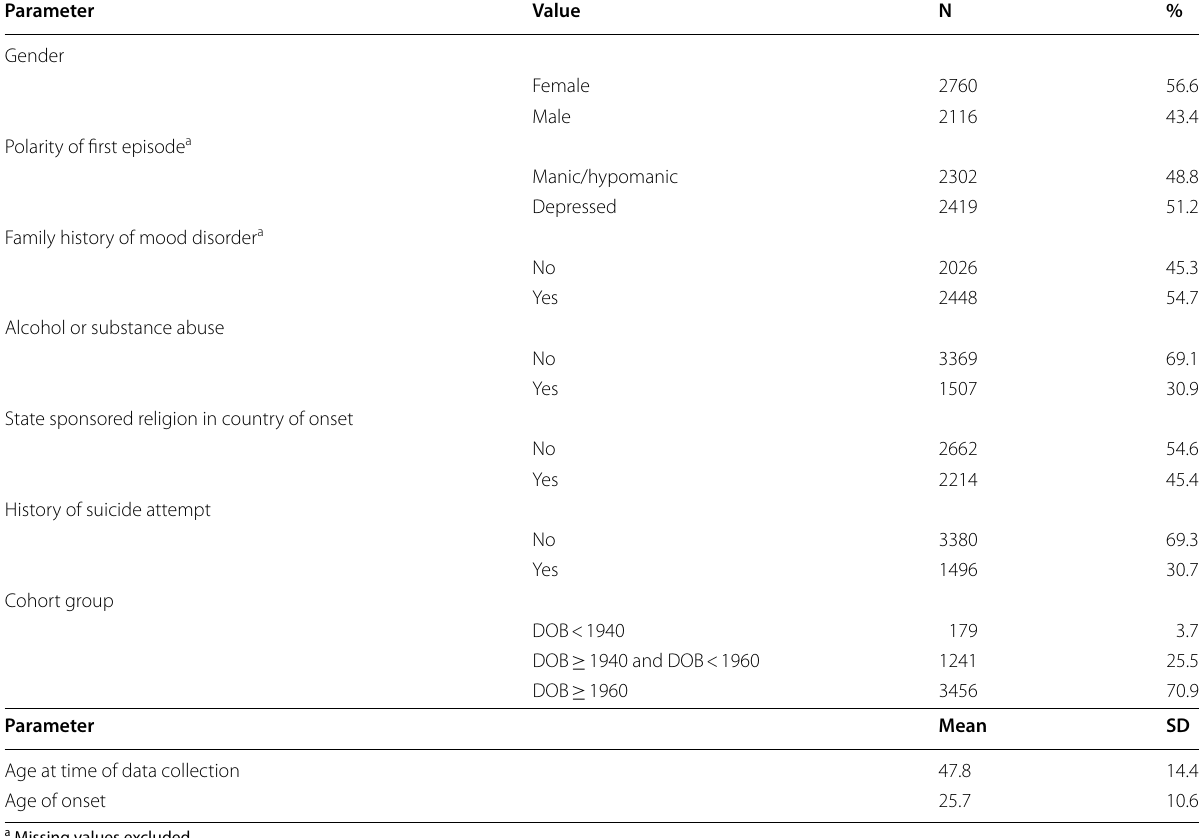
a Missing values excluded